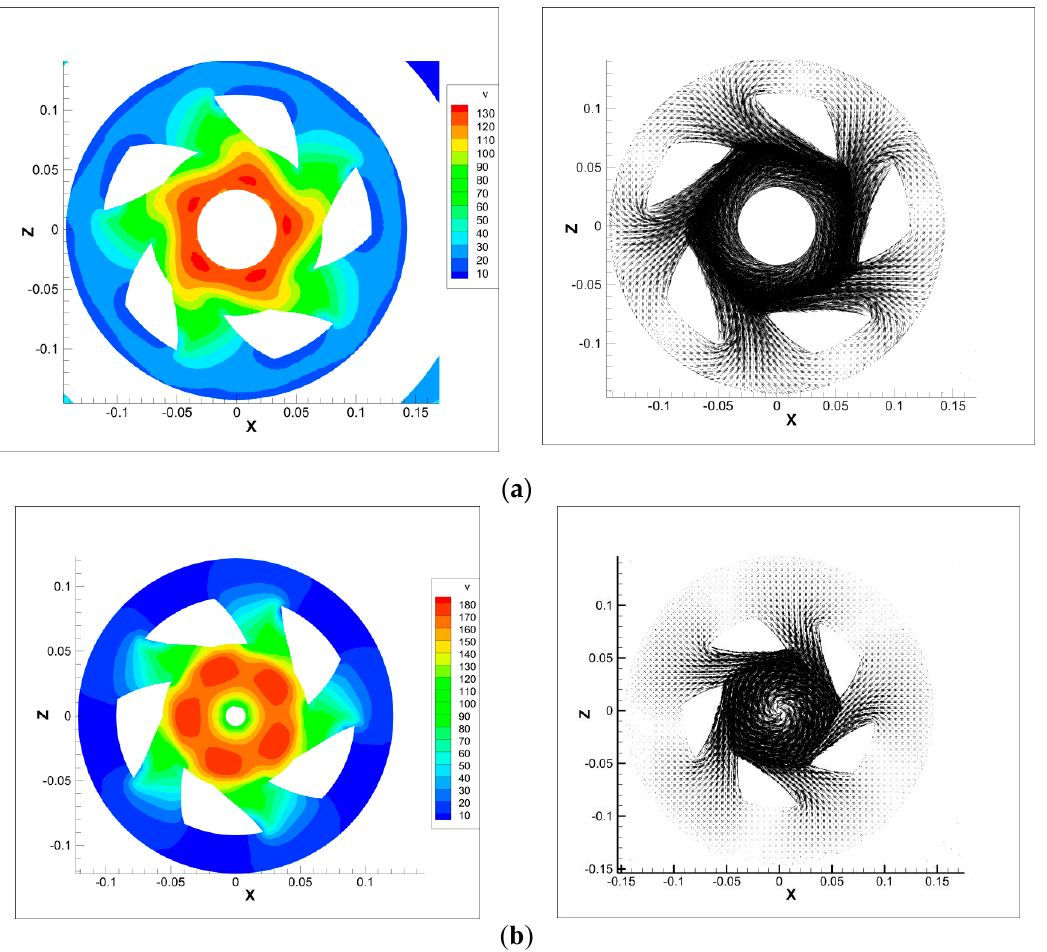
Figure 7. Numerical simulation results of cyclone nozzles simulated by the modified model: ( a ) ve-